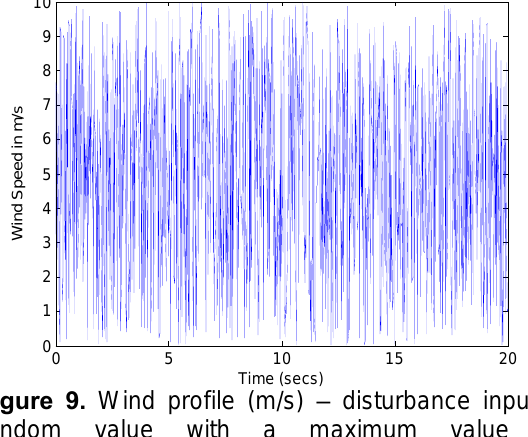
Figure 9. Wind profile (m/s) – disturbance input – random value with a maximum value of 10.0*(rand(1,nstep))m/s